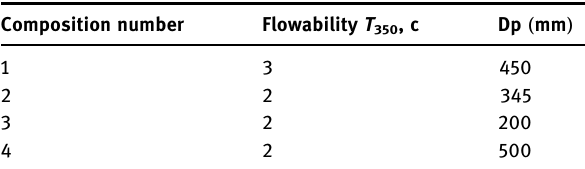
Table 15: Determination of concrete mixture fl owability Composition number